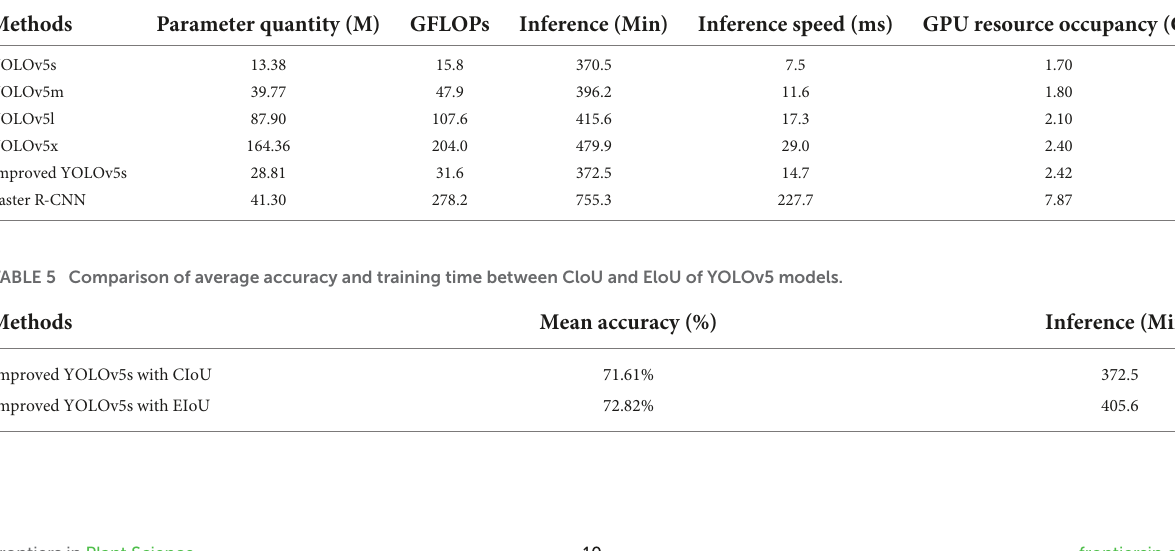
TABLE 4 Comparison of parameter quantity, GFLOPs, inference, inference speed, and GPU resource occupancy of different models.